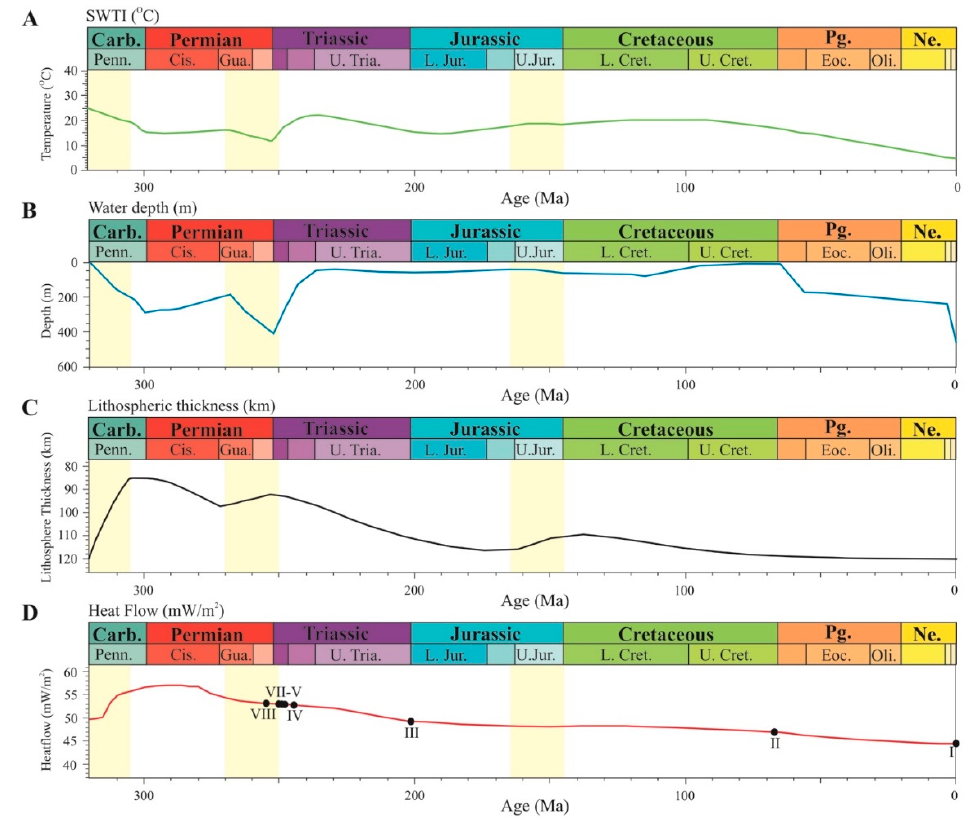
Figure 5. Modeled ( A ) sediment-water interface temperature (SWIT), ( B ) water depth, ( C ) lithospheric thickness, and ( D ) basal heat flow through time in the Nordkapp Basin. Yellow rectangles show the three rifting periods. Dots in D are the selected restoration stages in Figure 4.